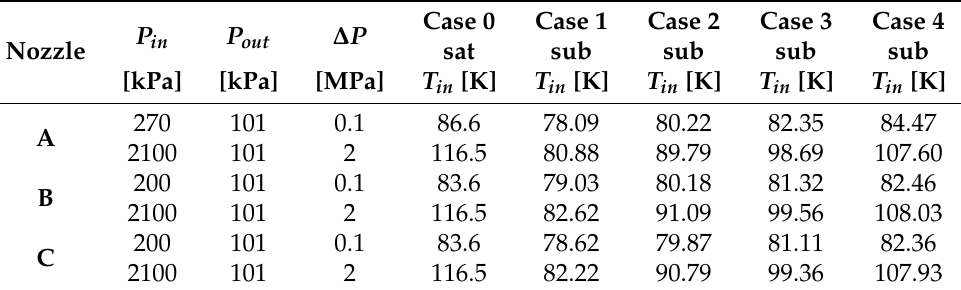
Table 2. Examples of the computed cases in [46]. Cases from 1 to 4 are performed in subcooled conditions, whereas Case 0 was made at saturation.Reprinted from [46], Copyright (2017), with permission from